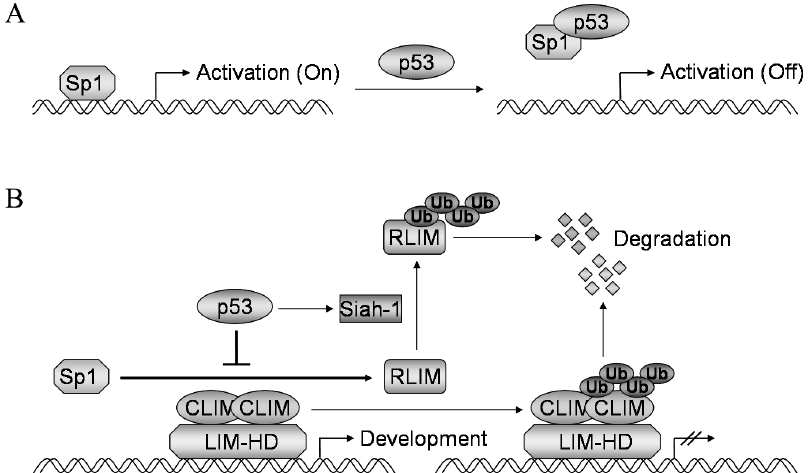
Figure 8. Mechanism of inhibition of RLIM by p53. ( A ) p53 directly interacts with and sequesters Sp1 from the RLIM promoter, thereby inhibiting the transcriptional activation of RLIM by Sp1. ( B ) Dual mechanism of inhibition of RLIM by p53. p53 inhibits the transcriptional activation of RLIM by Sp1. p53 also activates the expression of RLIM E3 ubiquitin ligase Siah-1, leading to the degradation of RLIM protein.